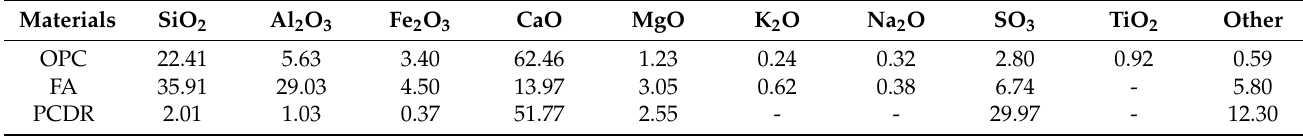
Table 4. XRF composition analysis of PCDR, OPC, and FA in the current study.